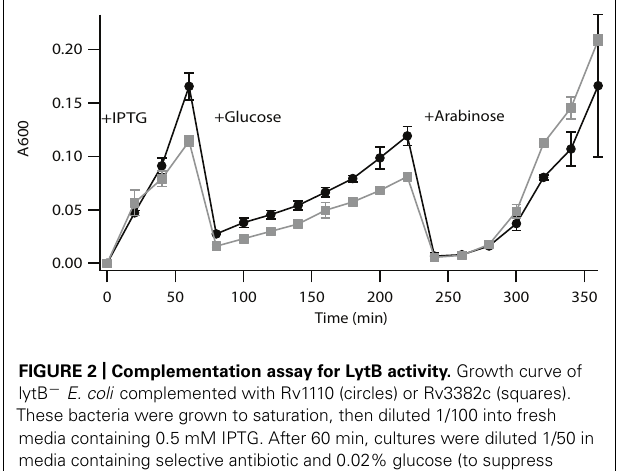
FIGURE 2 | Complementation assay for LytB activity. Growth curve of lytB − E. coli complemented with Rv1110 (circles) or Rv3382c (squares).